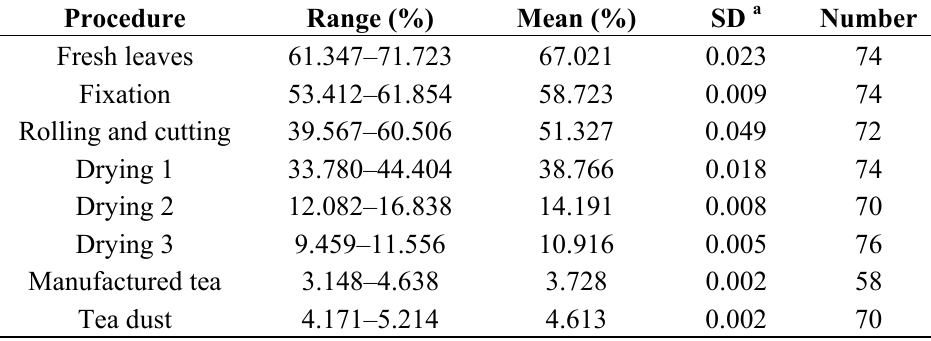
Table 4. Statistical information of moisture content (w.b., %) of samples in type